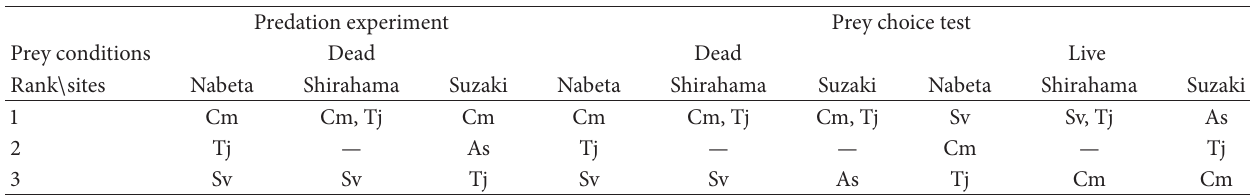
Table 1: Ranked prey preferences of the muricid snail Reishia clavigera from experiments using dead prey and prey choice tests using dead and live prey in Nabeta, Shirahama, and Suzaki, the southern Izu Peninsula, Shizuoka, Japan ( 𝑛 = 30 in predation experiment and prey choice test using dead prey, 𝑛 = 20 in prey choice test using live prey). Cm, Tj, Sv, and as indicate Capitulum mitella , Tetraclita japonica , S. virgatus , and A. senhousia , respectively